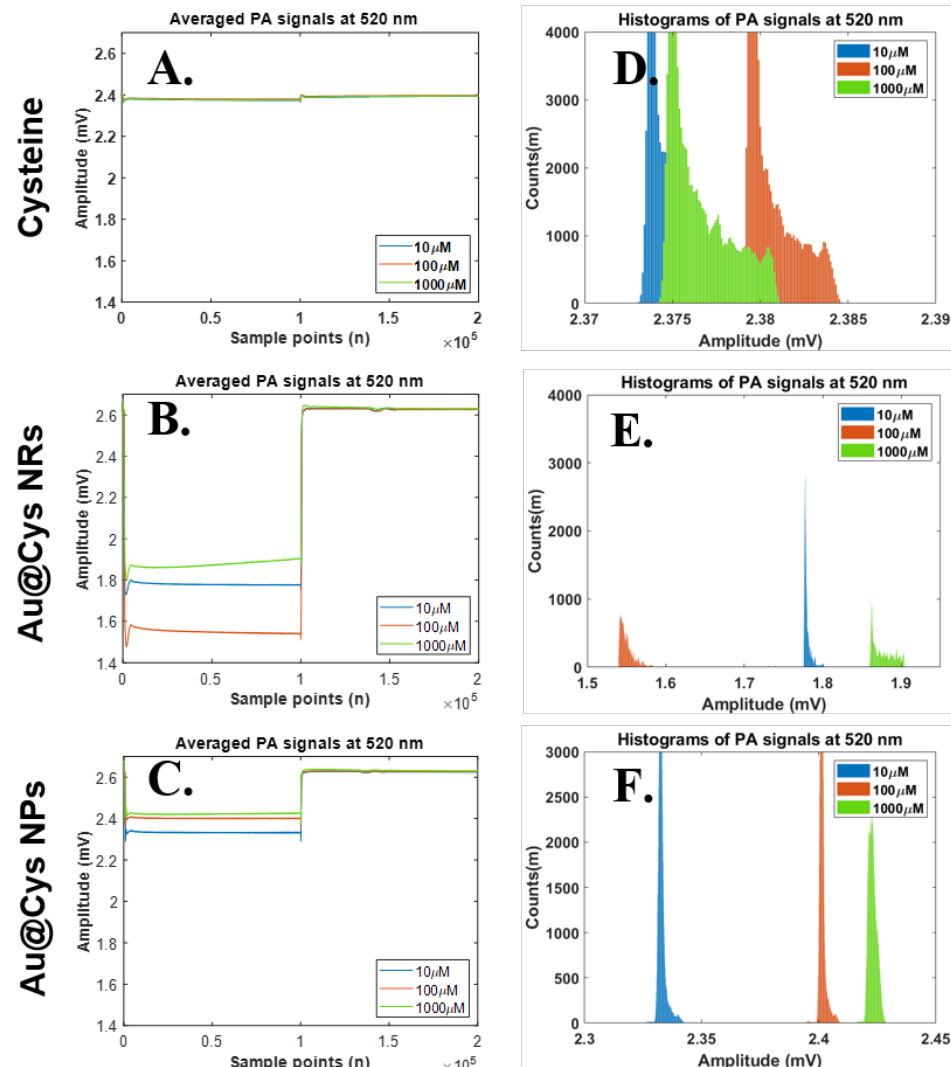
Figure 5. Relationships on time domain PA signals (upper) and their histograms (lower) at laser wavelength 520 nm. Statistical analysis results of histogram widths among three parameter sets, including 520 nm laser excitation, three substances (Cys, Au@Cys NRs and Au@Cys NPs), and three Cys concentrations (10, 100, and 1000 µ M). ( A – C ) Time domain PA signals from Cys, Au@Cys NRs, and Au@Cys NPs samples, respectively; ( D – F ) Histogram plots of PA signals ( A – C ) from Cys, Au@Cys NRs, and Au@Cys NPs samples, respectively.